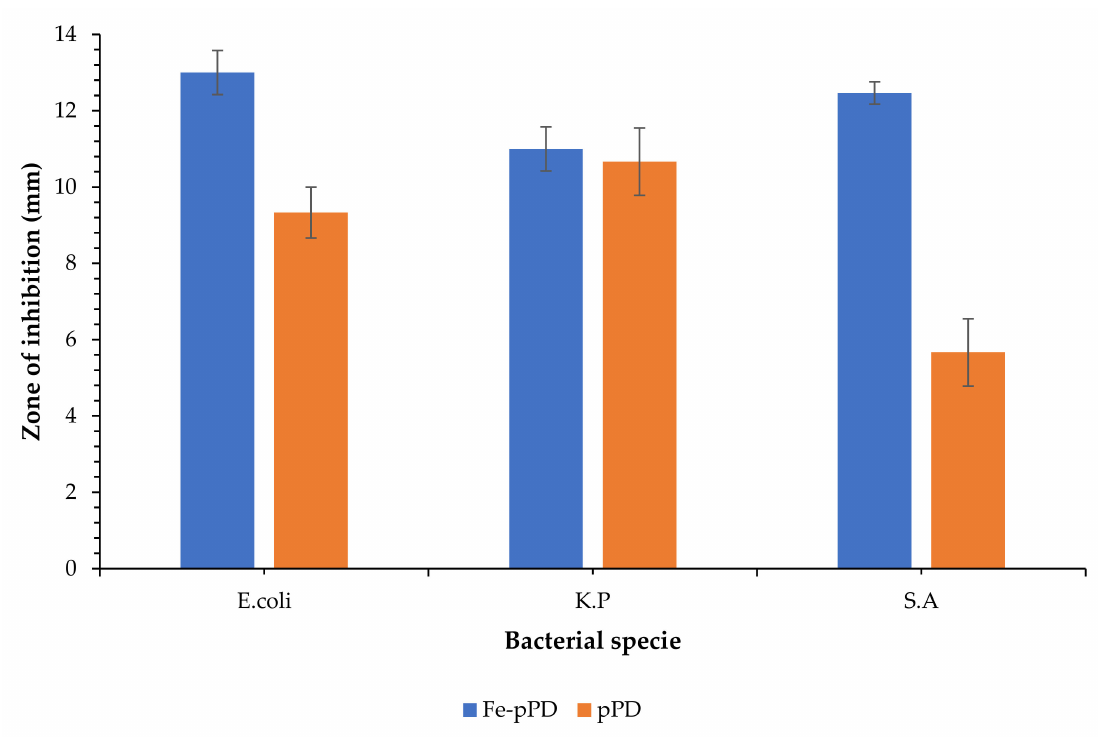
Figure 14. Antimicrobial activity of the Fe-pPD composite.